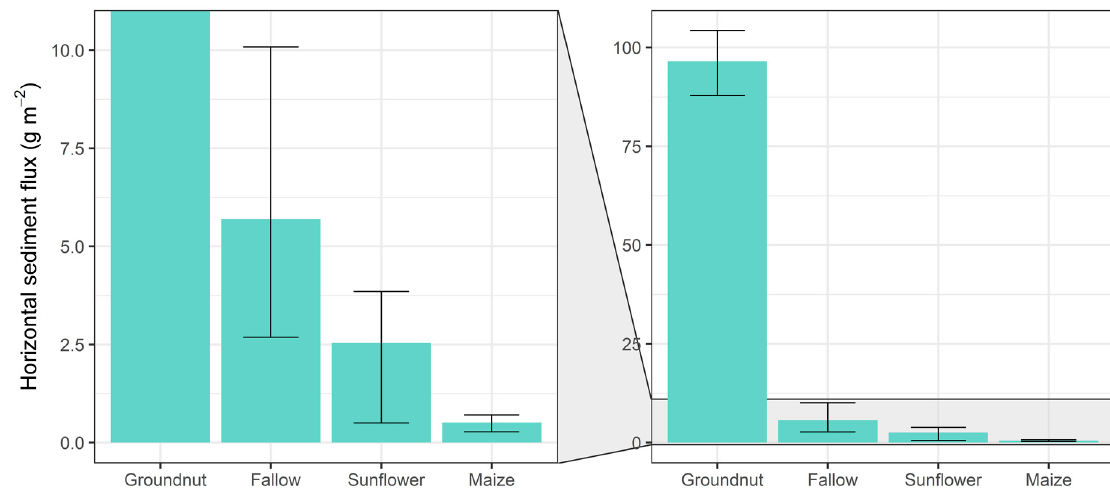
Figure 7. Average sediment flux on fields. Error bars illustrate maximum and minimum values.